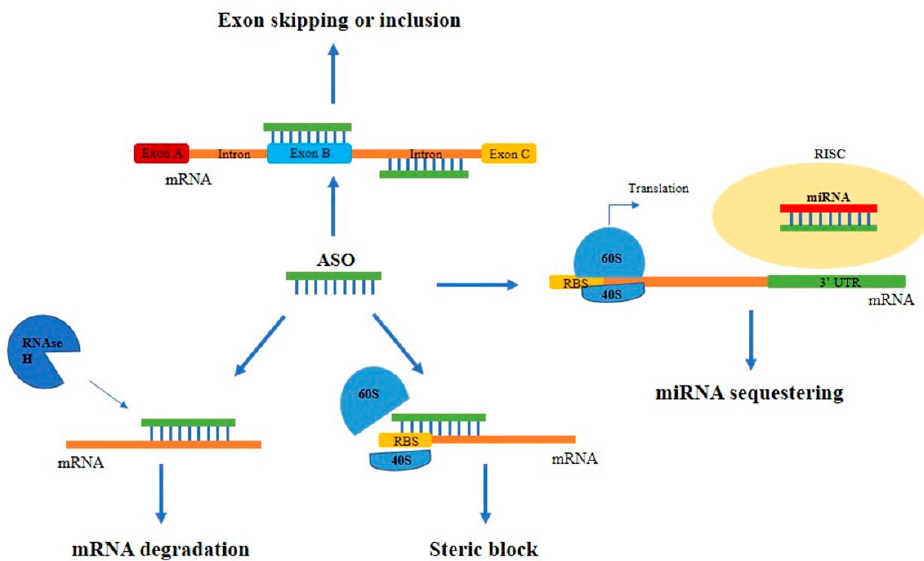
Figure 2. Main mechanisms of action of ASOs. Schematic representation of the different mechanisms of action of ASOs. ASOs can block protein expression by binding to the mRNA and leading to: (i) the RNase H-mediated mRNA degradation; (ii) the steric block of the correct ribosomal assembly; iii) the alteration of the normal splicing causing exon skipping or inclusion. Alternatively, they can sequestrate miRNAs avoiding their binding to target mRNAs.